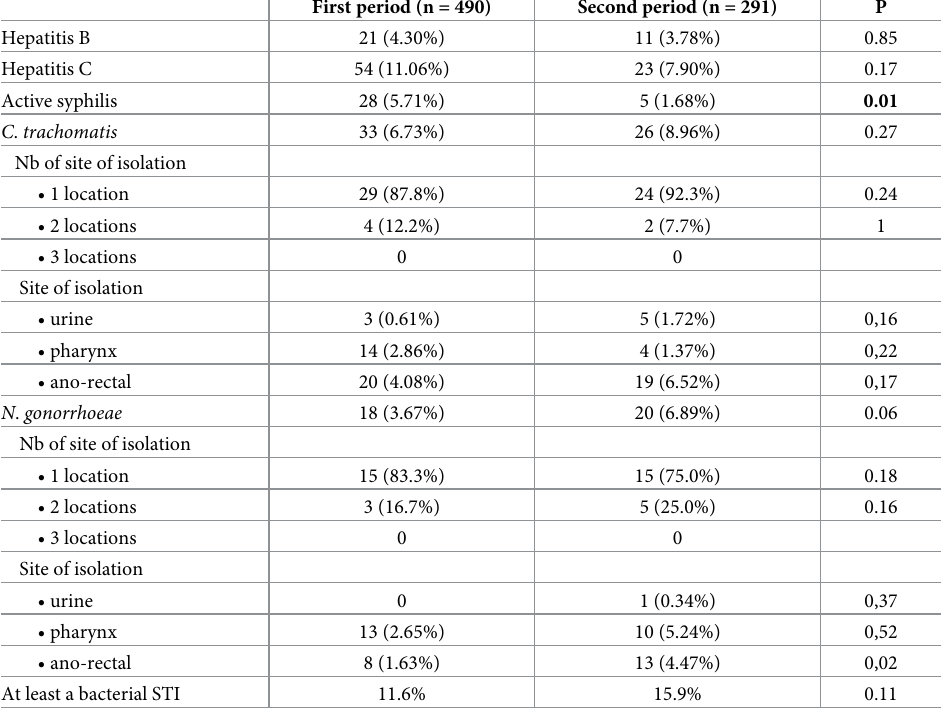
Table 3. Asymptomatic co-infection screened at